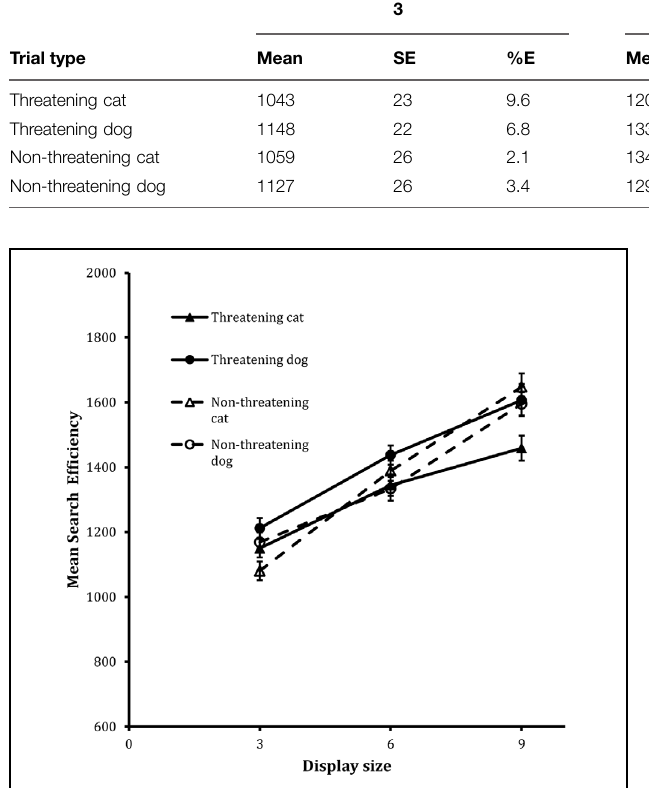
FIGURE 2 | Mean search efficiency scores as a function of both condition and display set size in the classification task in Experiment 1. Error bars reflect within-participant SE after variation between participants was removed (after Bakeman and McArthur, 1996).